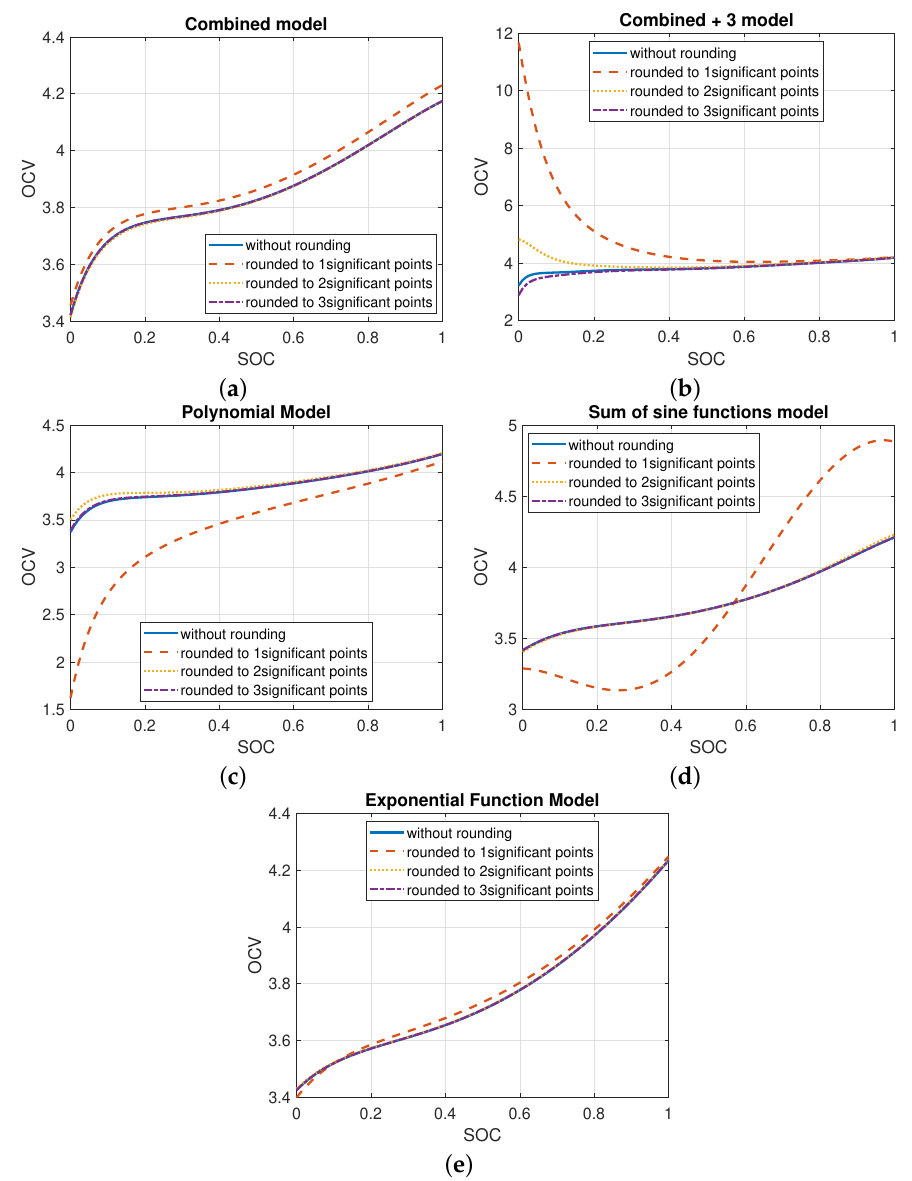
Figure 4. Rounding effects on accuracy in parametric models—( a ) combined, ( b ) combined + 3, ( c ) polynomial, and ( d ) sum of sine functions ( e )